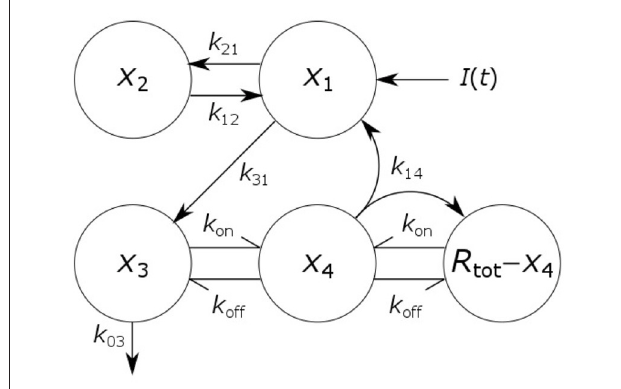
FIGURE 1 | Schematic of four-compartment model of IgG metabolism. Arrows represent material flow between compartments and hooked arrows represent nonlinear receptor-ligand binding. The fifth compartment shown ( R tot − x 4 ) represents unbound FcRn receptors and has been eliminated from the model equations. The arrow, labeled k 14 , from the IgG-FcRn complex compartment ( x 4 ) to the unbound FcRn receptor compartment ( R tot − x 4 ), represents internalization of FcRn receptors from the plasma membrane to the endosome, after releasing